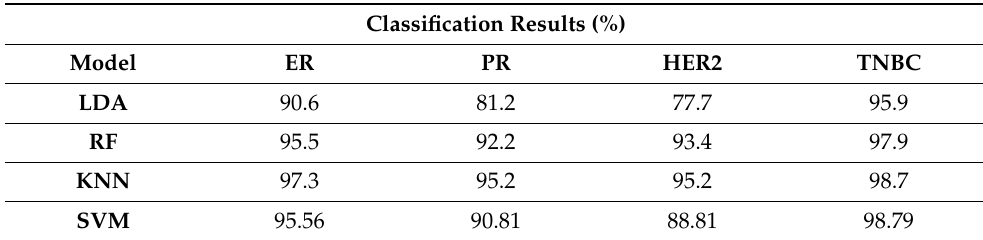
Table 1. Classification outcome. LDA—Linear discriminant analysis; RF—Random Forest; KNN— k-nearest neighbors; SVM—Support vector machine.